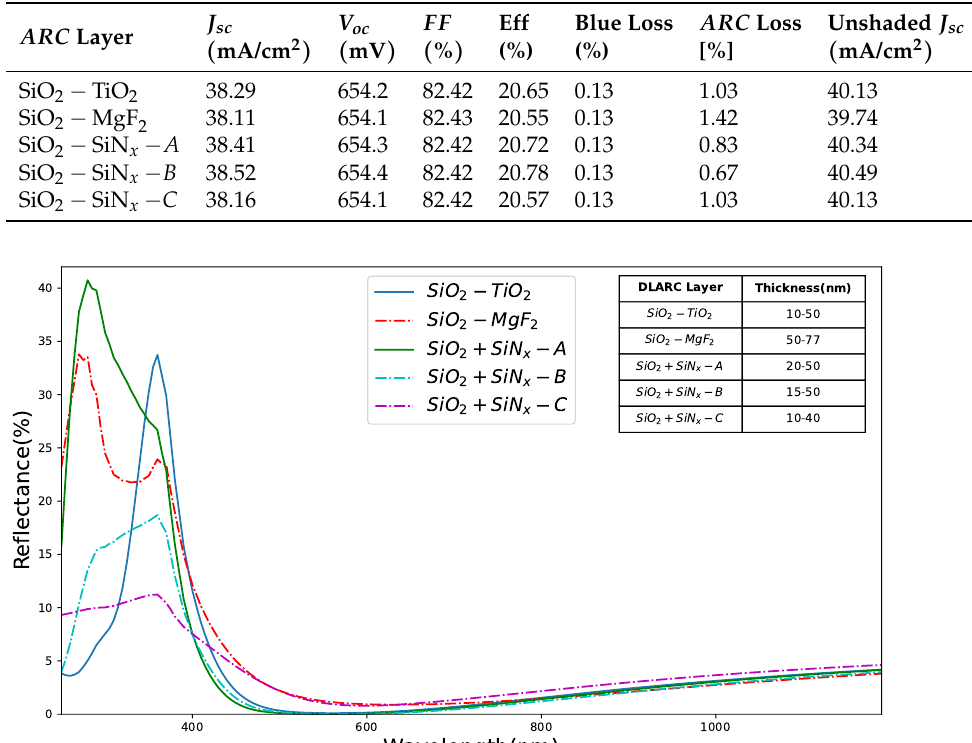
Table 3. I − V parameters and ARC loss calculation based on the optimized DLARC layers.